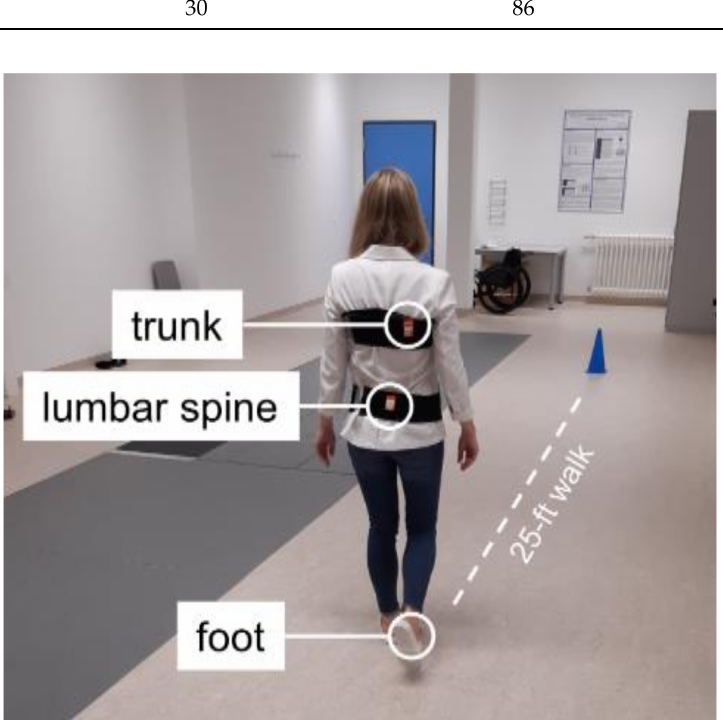
Figure 1. Experimental setup. Both PwMS and healthy participants had to complete a walking test that required them to cover a distance of 25 feet (7.62 m) repeatedly throughout a maximal assess- ment period of six minutes. Wearable inertial sensors were attached to the forefoot of participants’ dominant foot (foot), and with an elastic belt to the right scapula (trunk) and lumbar spine (at L5 to approximate body center of